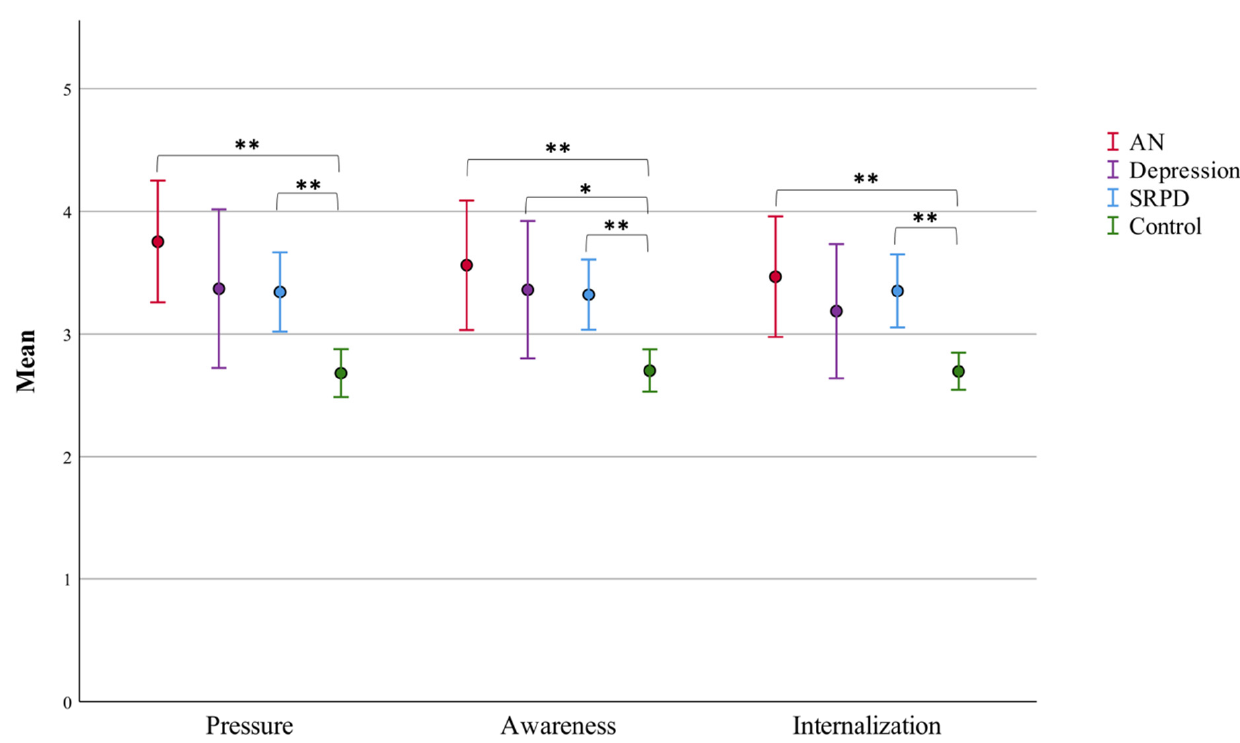
Figure 2. SATAQ scores by group with 95% confidence interval error bars; results of ANOVAs with pairwise post hoc Bonferroni corrections for number of tests (* p < 0.05, ** p < 0.01) (SATAQ, Sociocultural Attitudes Towards Appearance Questionnaire).